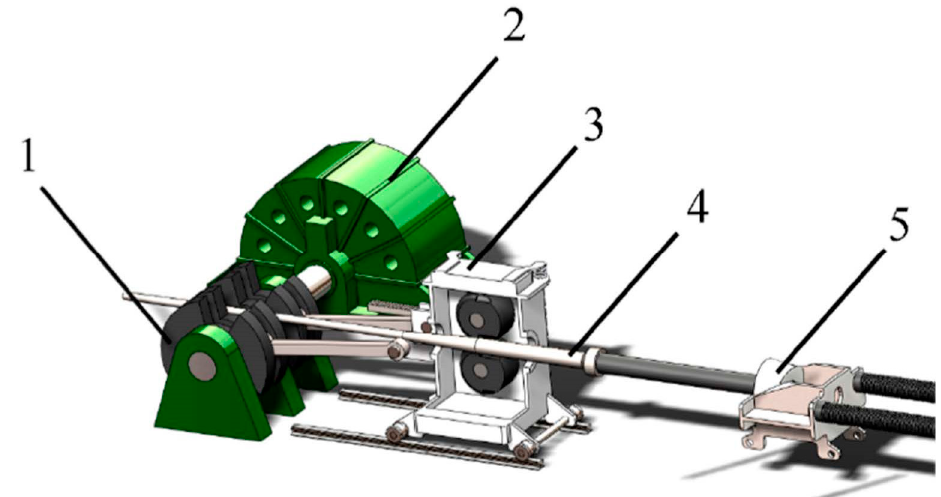
Figure 1. Pipe cold-rolling mill: 1—crank mechanism; 2—rolling stand motor; 3—rolling stand; 4—pipe billet; 5—auxiliary pipe feeding and turning mechanisms.